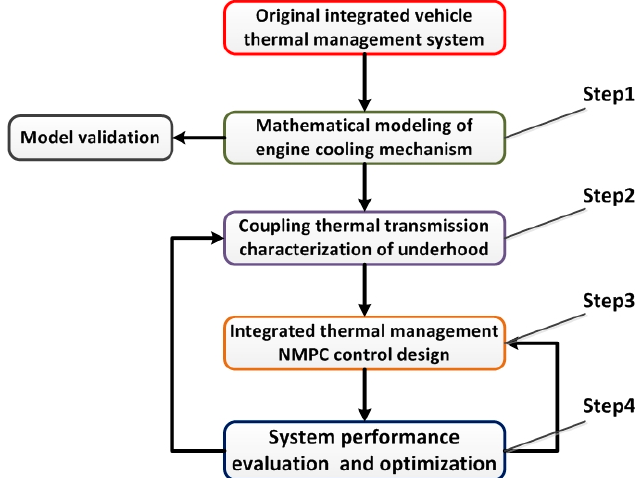
Figure 2. Integrated thermal management system optimization control technology route.